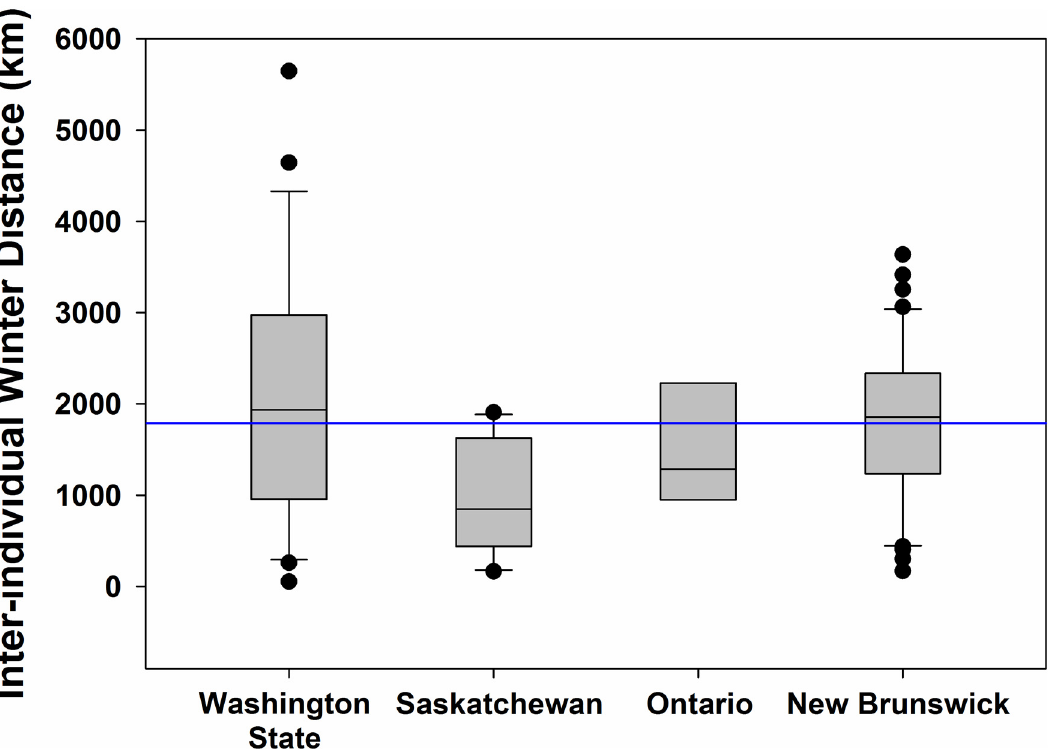
Fig 2. Inter-individual distances (km) between wintering sites (from mean wintering location; see Methods) of barn swallows fit with archival light- level geolocators from four populations in North America. The horizontal midlines within the boxes represent the median value, boxes depict the 25 th to 75 th percentile range of the data, the whiskers extend 1.5 times beyond the interquartile range, black circles indicate outliers and the horizontal blue line denotes the overall mean of inter-individual wintering distances (1,788